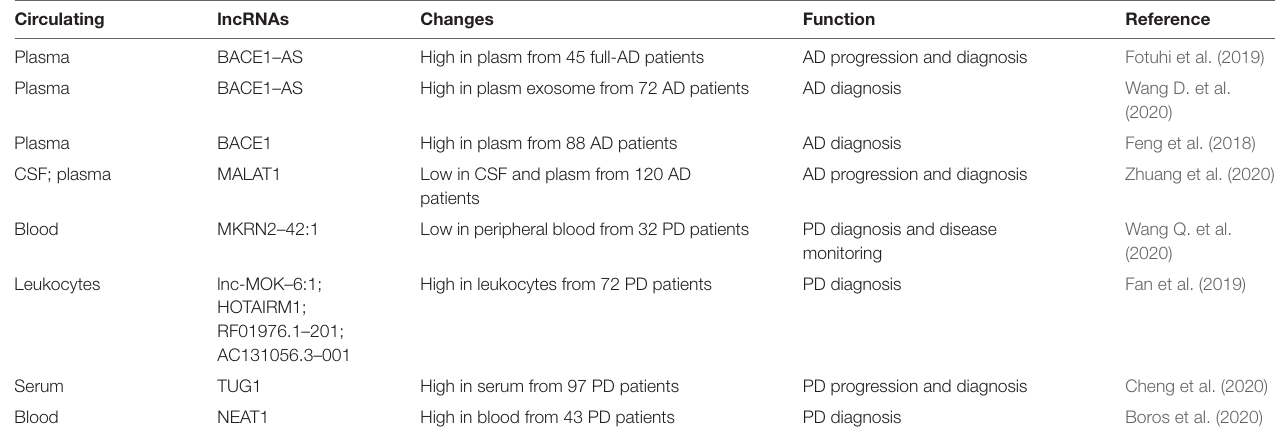
TABLE 2 | Circulating lncRNA associated with